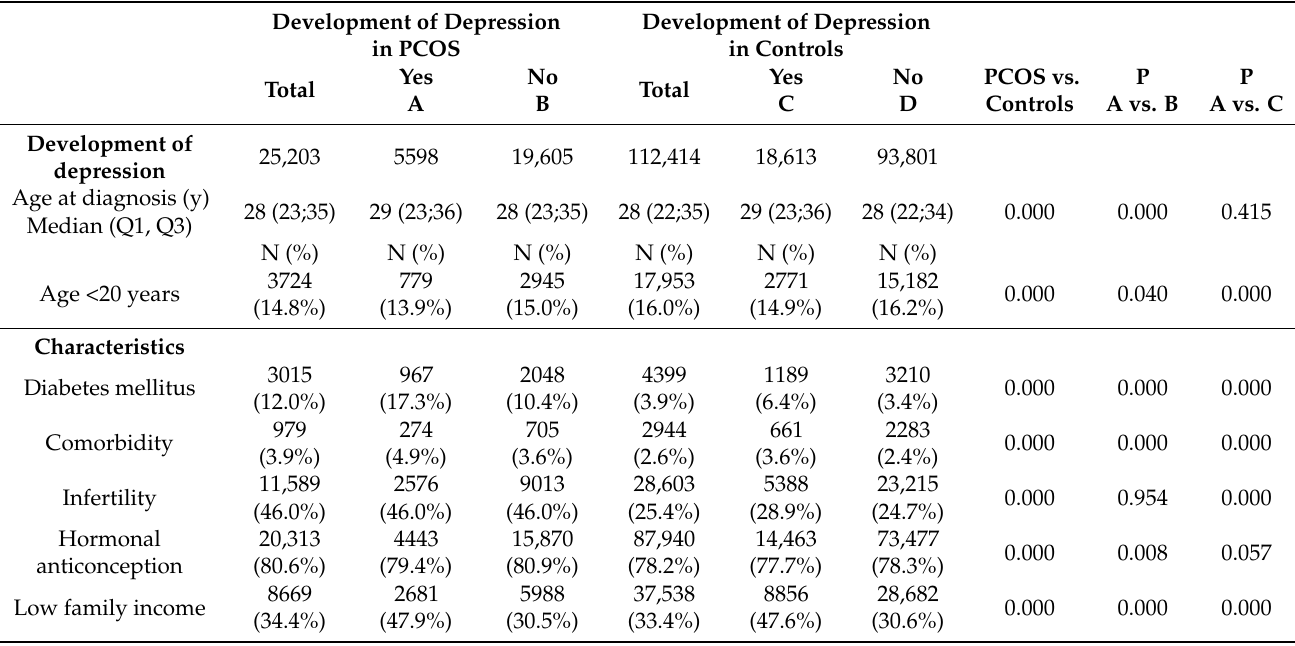
(Table 5). Women in PCOS OUH who developed depression had higher baseline BMI (27.7 vs. 26.4 kg/m 2 ) and higher FG score (12 vs. 10) compared to women in PCOS OUH